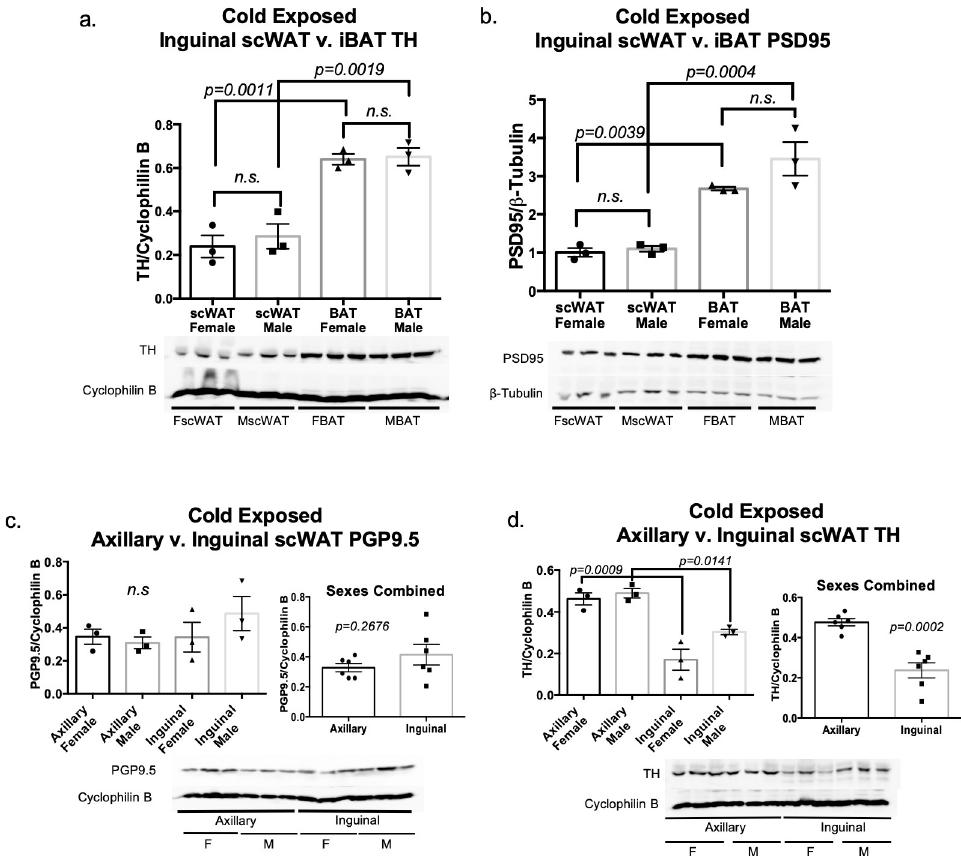
Fig 6. Adipose innervation: Sex and depot comparison. Adult (16 week old) male and female control mice on a C57BL/6J background were cold exposed (5˚C) for 3 days. Protein expression of TH (a) and PSD95 (b) were measured in inguinal scWAT and BAT via western blotting. Protein expression of pan-neuronal marker PGP9.5 (c) and sympathetic nerve marker TH (d) was measured in axillary and inguinal scWAT for both sexes via western blotting. Protein expression was normalized to β -Tubulin or Cyclophilin B, band density was quantified in Image J and analyzed using a Two-Tailed Student’s t-test. Error bars are SEMs.